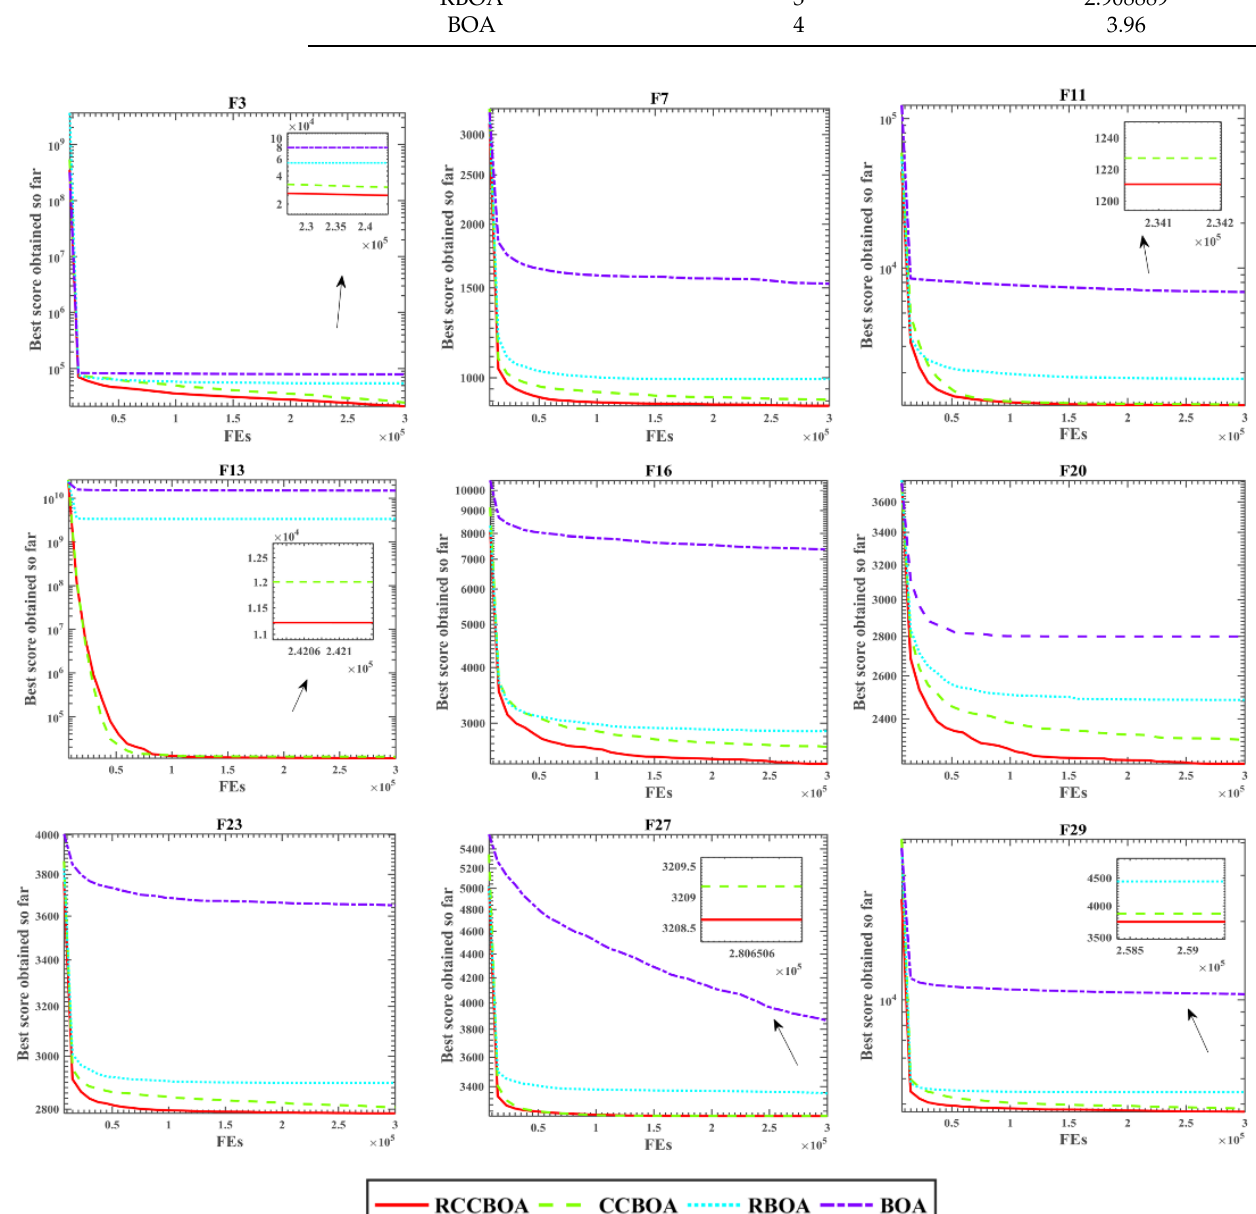
Figure 3. Mechanism combination